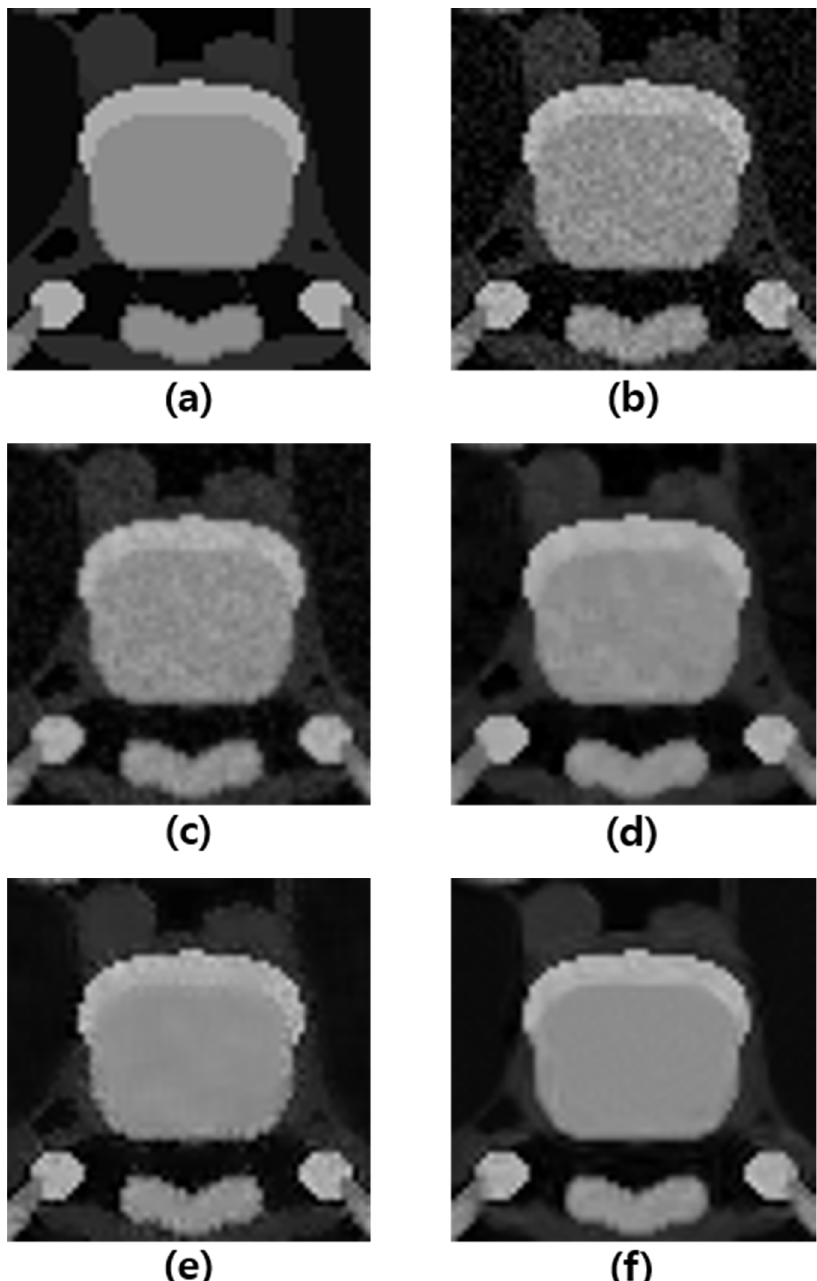
Figure 3. Magnified views (region inside the blue box). ( a ) Original; ( b ) Noisy; ( c ) Gaussian filtered; ( d ) Median filtered; ( e ) Wiener filtered; ( f ) Fast non-local means (FNLM) filtered images.